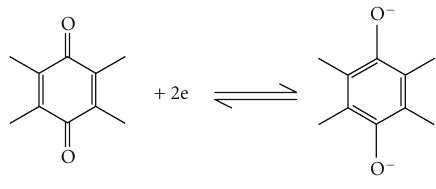
Scheme 3: Structure of adriamycin and